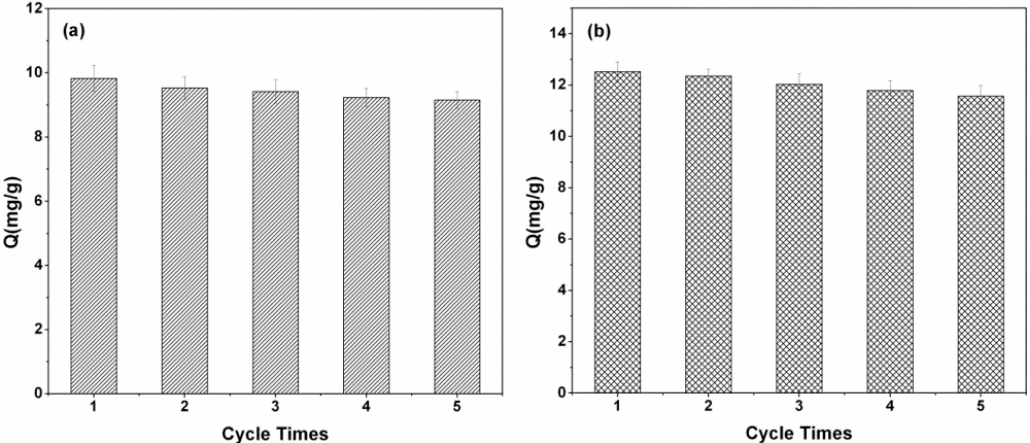
Figure 14. Regeneration experiments for ( a ) Fe 3 O 4 -CTs@MIP and ( b ) Fe 3 O 4 -MAH- β -CD@MIP.